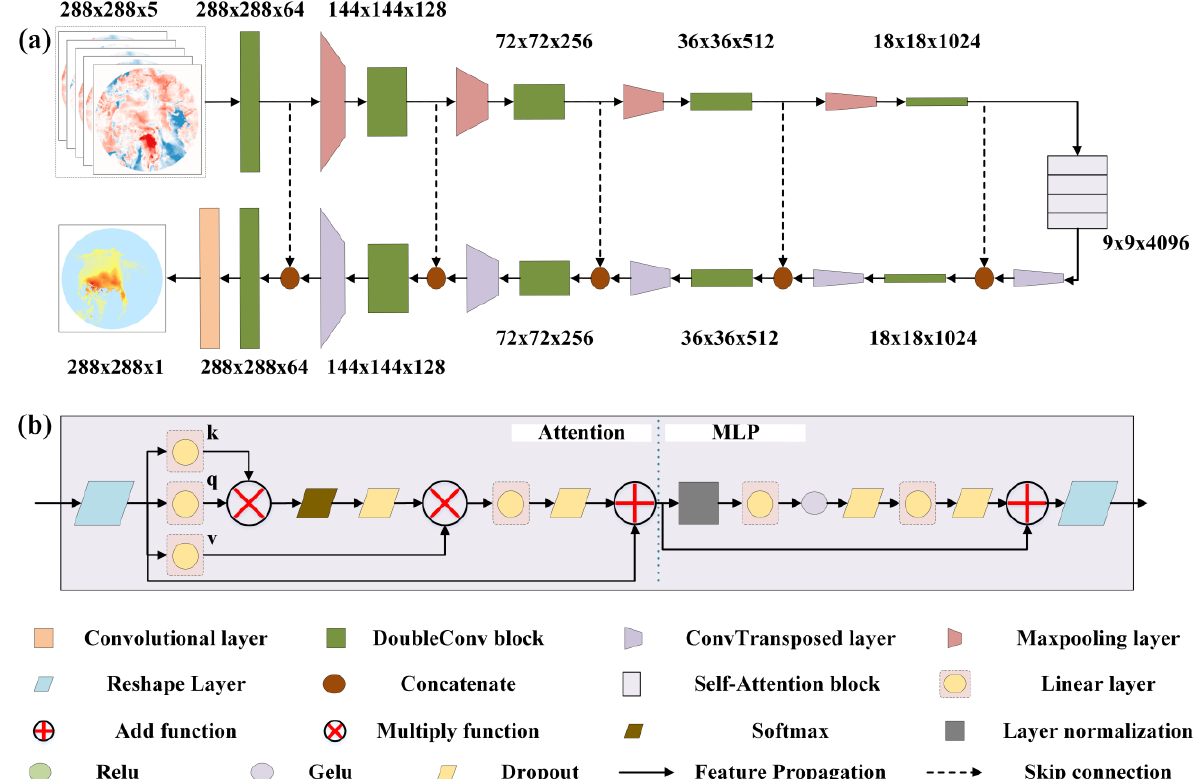
Figure 3. Structure of SAC-Net as proposed in this study. ( a ) The overall structure of the proposed SAC-Net and the 3D numbers representing the feature dimensions after the convolutional opera- tion; ( b ) the structure of the self-attention